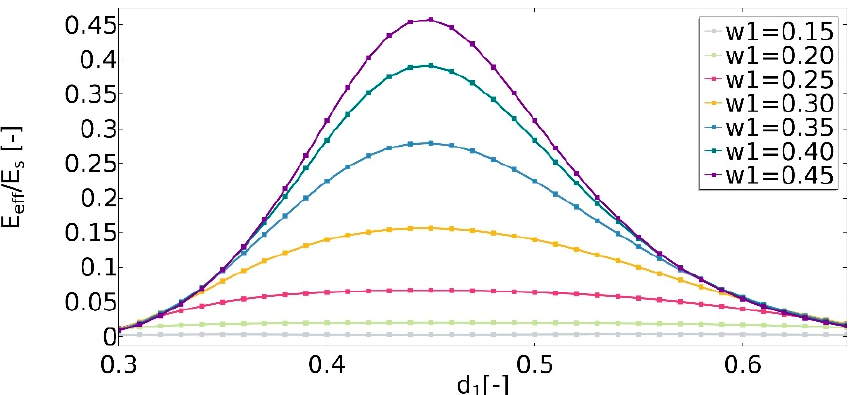
Figure 15. The influence of geometric features on the value of the ratio of the effective Young’s modulus to Young’s modulus of structure.